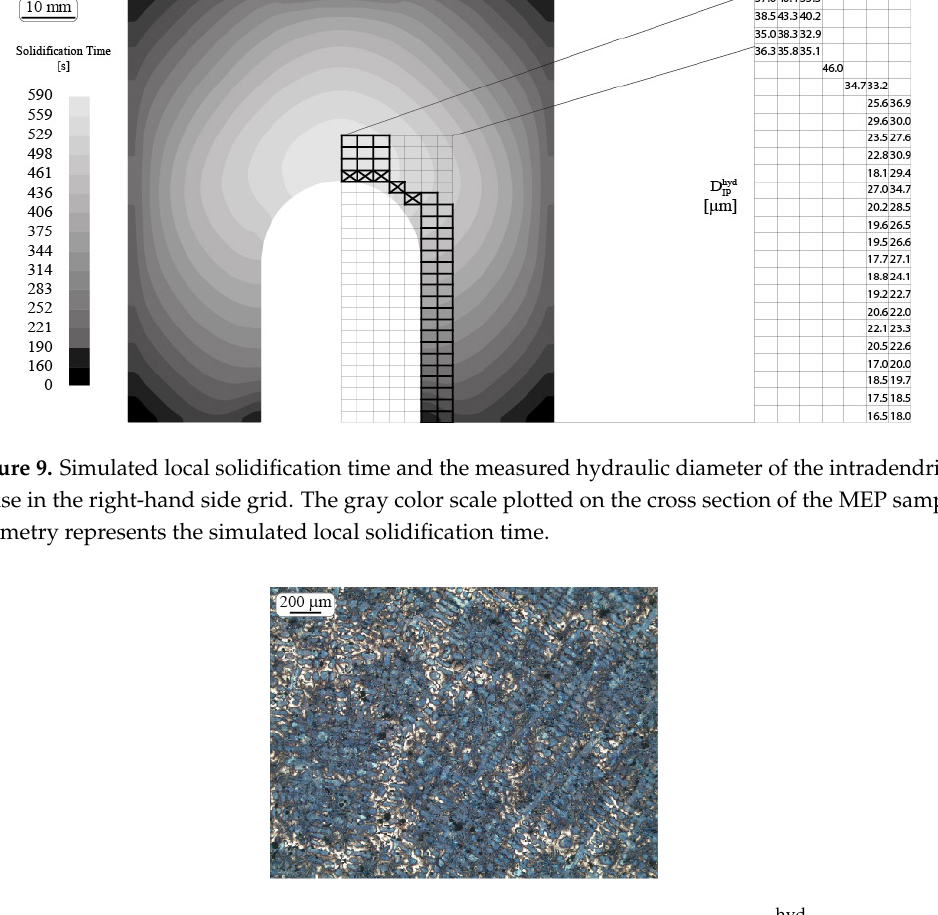
hyd D = 18.5 μ m and IP